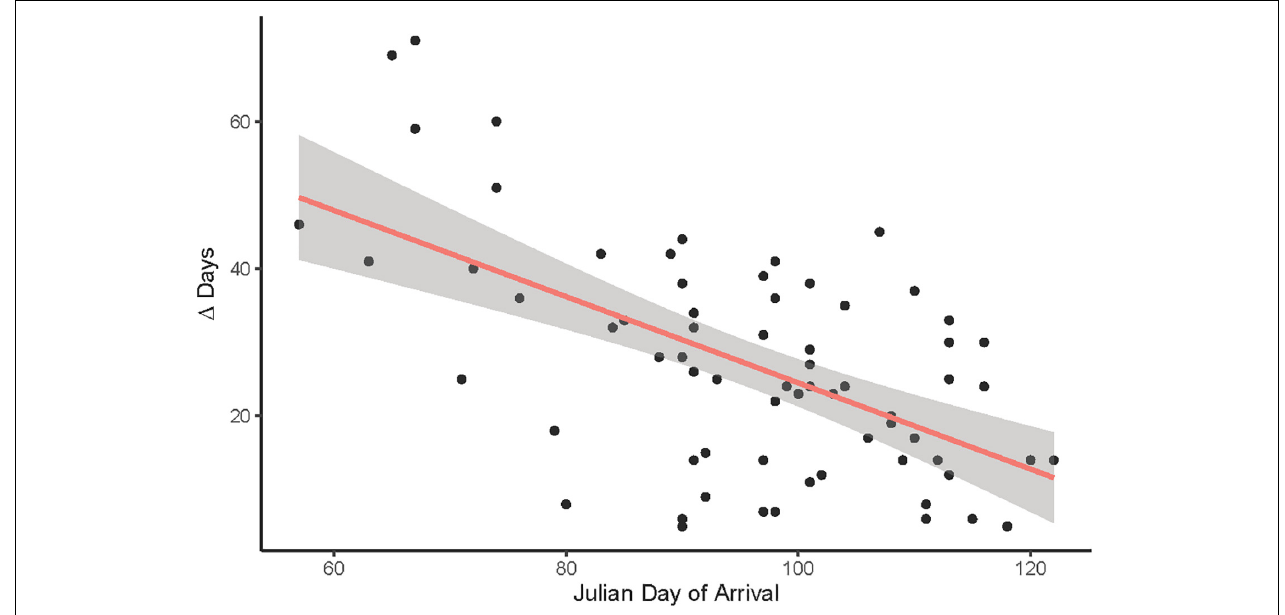
FIGURE 7 | The time gap between arrival and egg-laying date ( (cid:49) Days) shortens for later arrival dates when pooling corresponding arrival and egg-laying observations from all years ( n = 68). R 2 = 0.28, P <